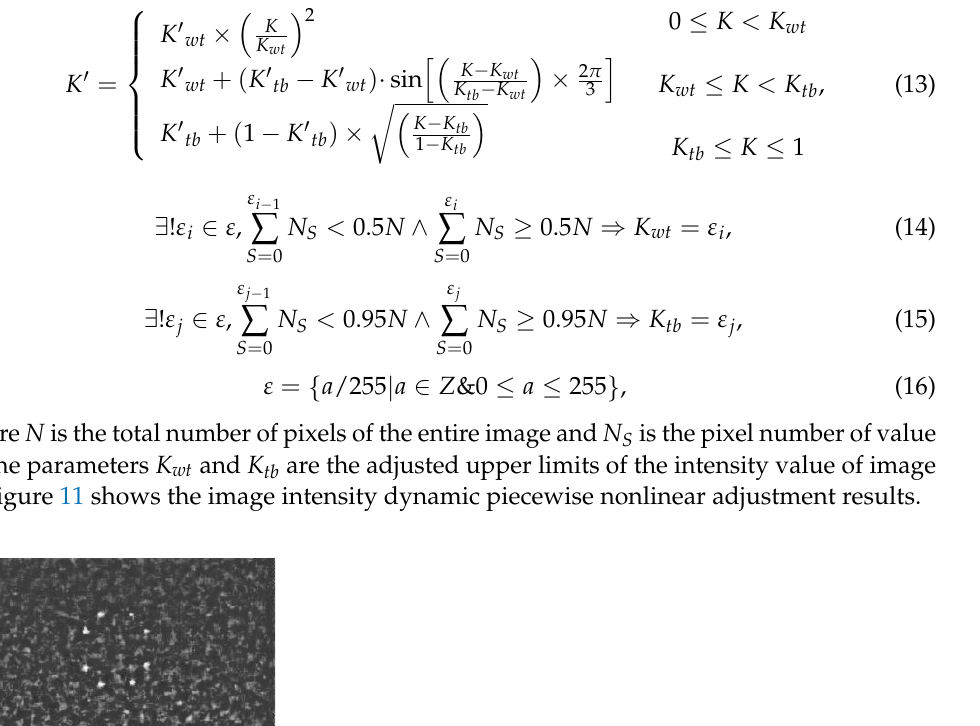
Figure 11. Results of image intensity dynamic piecewise nonlinear adjustment (image K ).